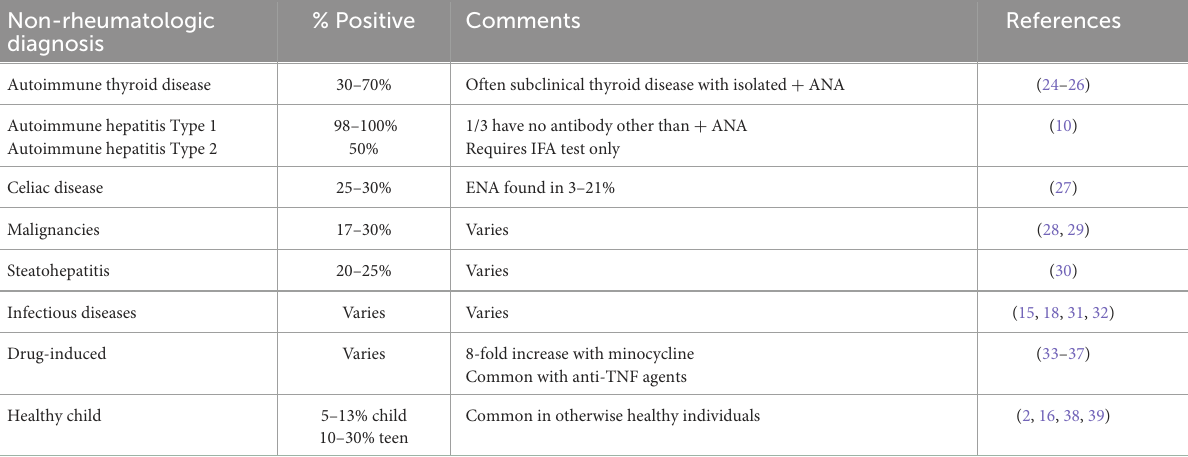
TABLE 2B Non-rheumatologic diagnoses with positive